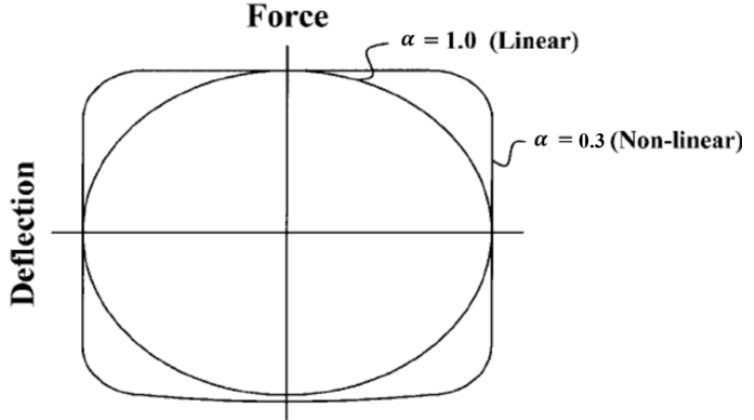
Figure 6. Hysteresis loops for linear and nonlinear dampers for two values of the damping exponent